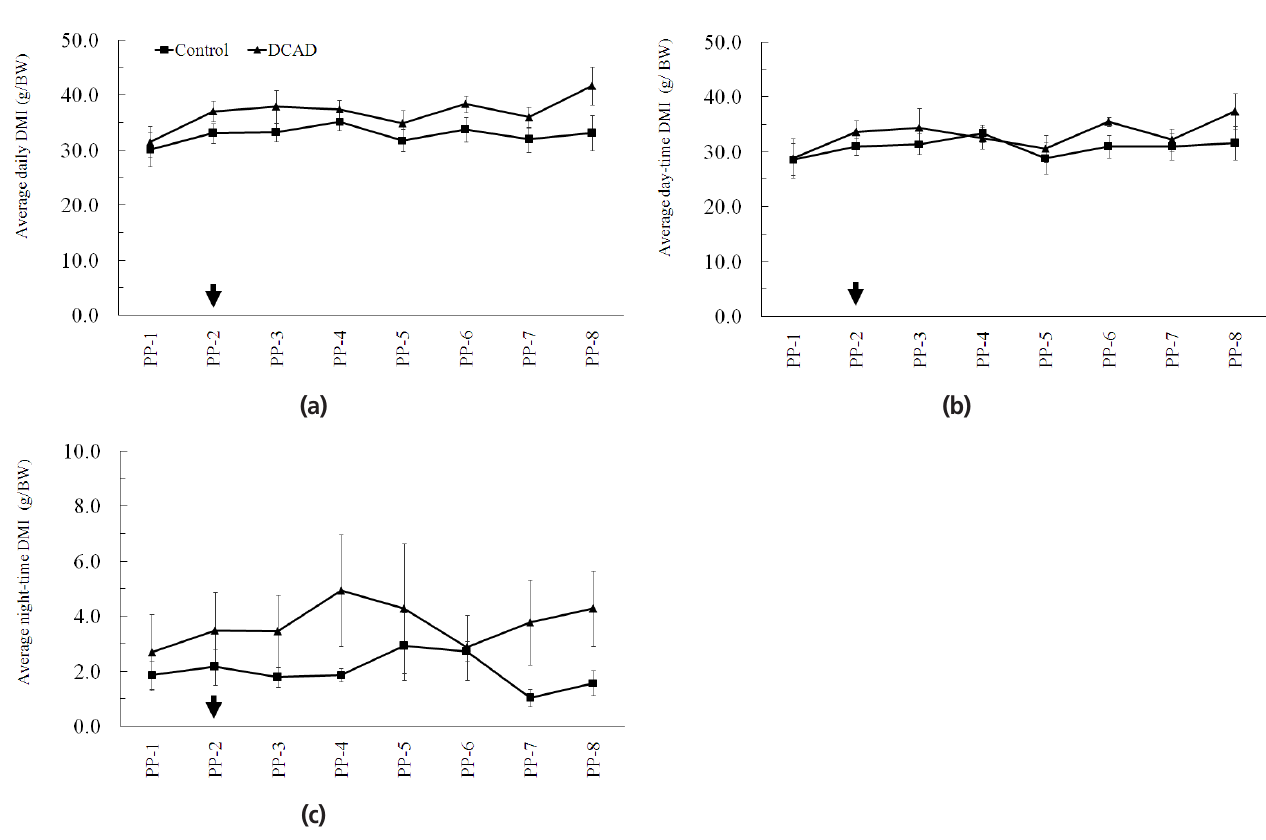
Figure 1. Effect of high dietary cation and anion difference on dry matter intake (DMI). Control or dietary cation anion different (DCAD) rations were provided from the 2nd week postpartum (PP-2, arrow) and DCAD effect was observed until the 8th postpartum (PP-8). The average daily DMI from both day and night time was measured manually from each week. There were no effects of DCAD on the average daily DMI (a), day-time DMI (b), and night-time DMI